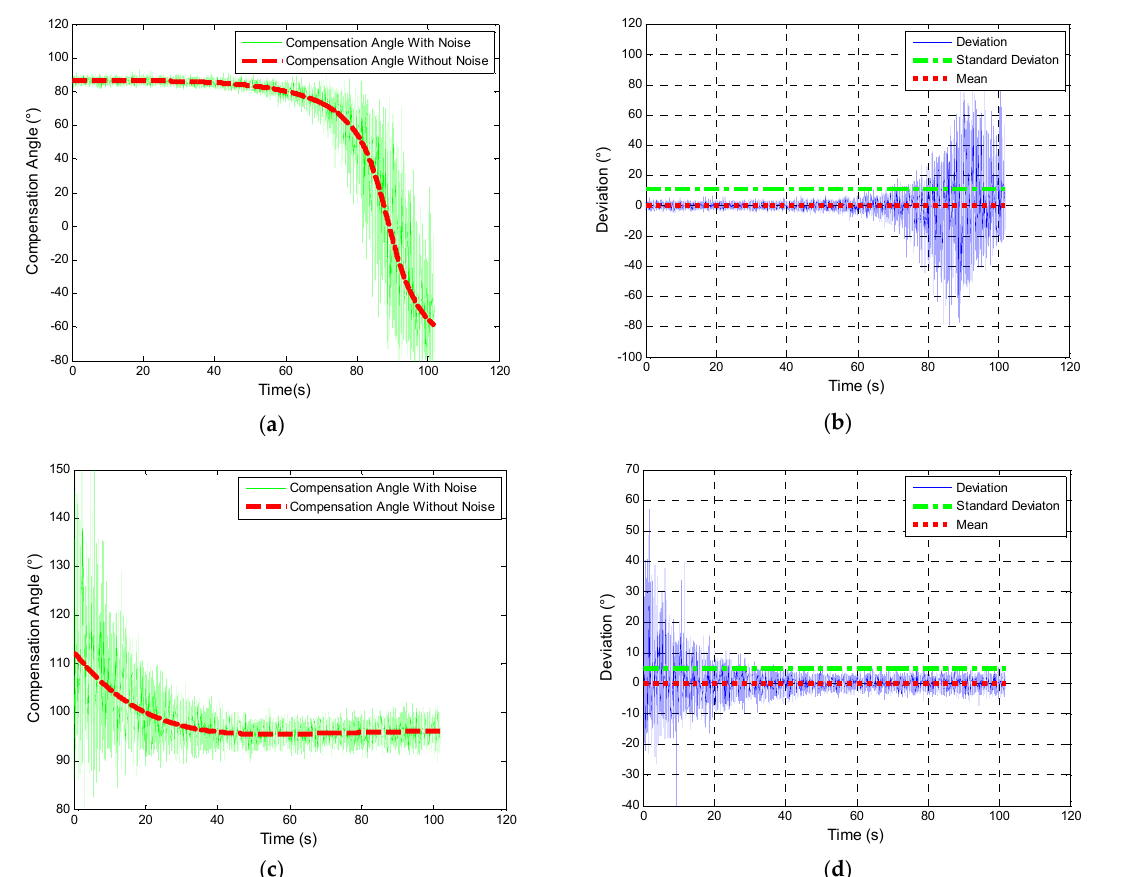
Figure 17. Compensation angle and deviation when yaw is 0° and 180°: ( a , c ) Description of compensation angle in the north and south direction and ( b , d ) description deviation of compensation angle.